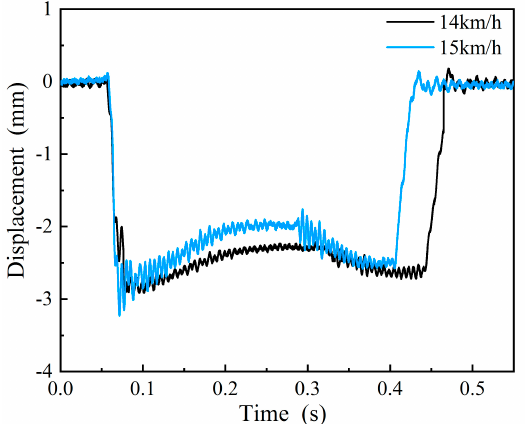
ff erent vehicle speeds on site.